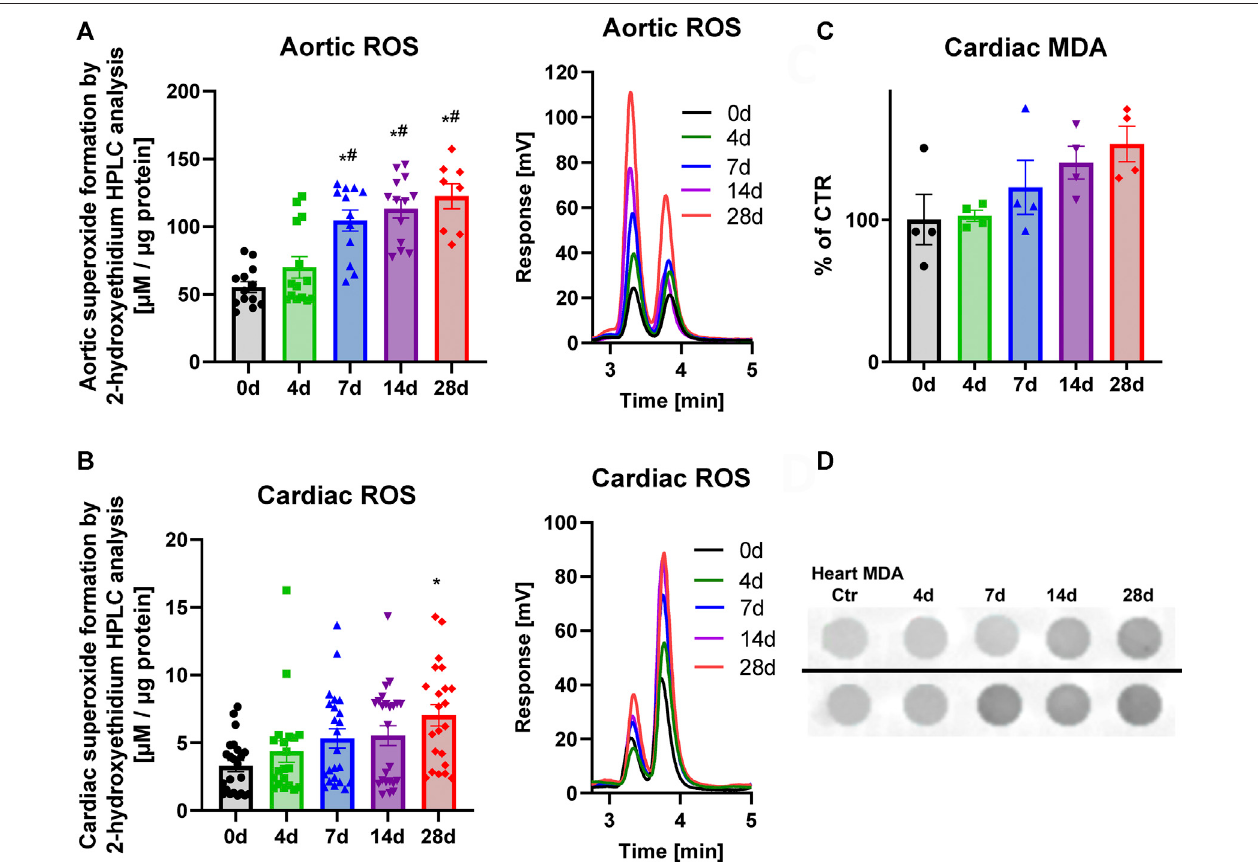
FIGURE 3 | Effects of long-term aircraft noise exposure on vascular and cardiac ROS formation. Levels of superoxide (measured with an HPLC-based dihydroethidium method) showed a progressive increase during noise exposure in both aorta (A) and heart (B) . Representative chromatograms for measurements are alongside the quanti fi cations. (C) Lipid peroxidation was assessed by MDA-positive proteins in the heart and showed a gradual increase with the noise exposure time. (D) Representative originaldot blot images are shown for all groups. Data points represent individual animals, n (cid:1) 12 – 14 (A) and n (cid:1) 22 – 24 (B) . Data points for (C) are pooled heart samples, representing two to three animals per point. Statistical analysis was done with one-way ANOVA with Tukey ’ s multiple comparison test. p < 0.05: * vs respective to 0d, # to 4d, $ to 7d, § to 14d and + to 28d.